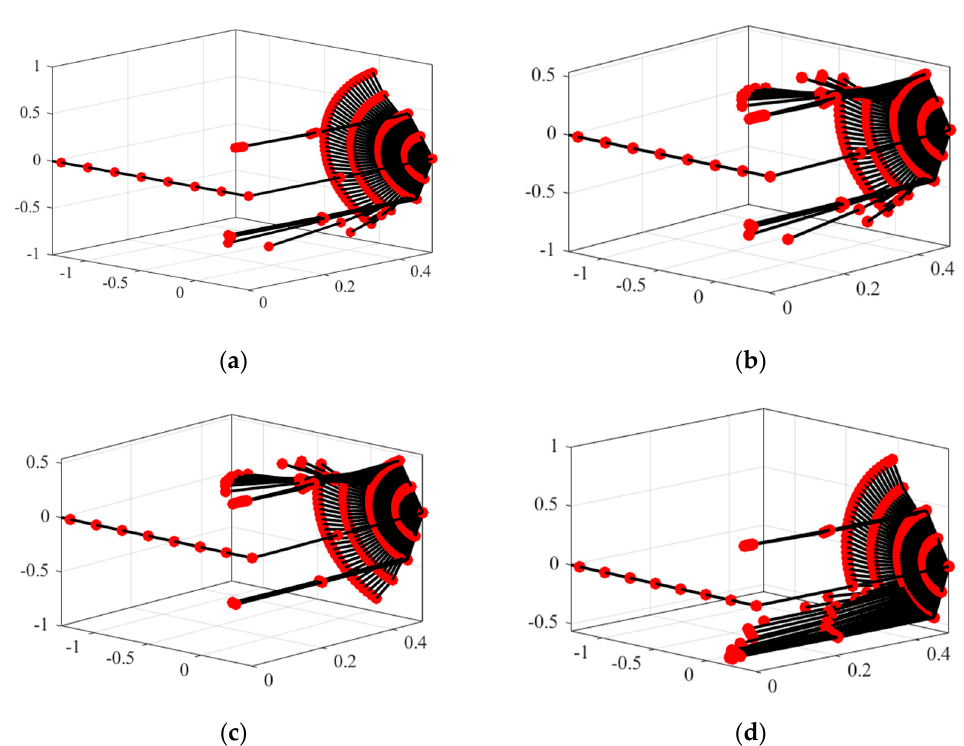
Figure 31. Reconfiguration processes of SMSRS under four collision-free paths. ( a ) path 1, ( b ) path 2, ( c ) path 3 and ( d ) path 4.